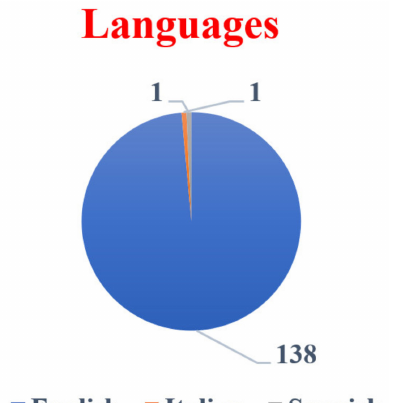
Figure 3. Language-wise distributions in health sciences research.